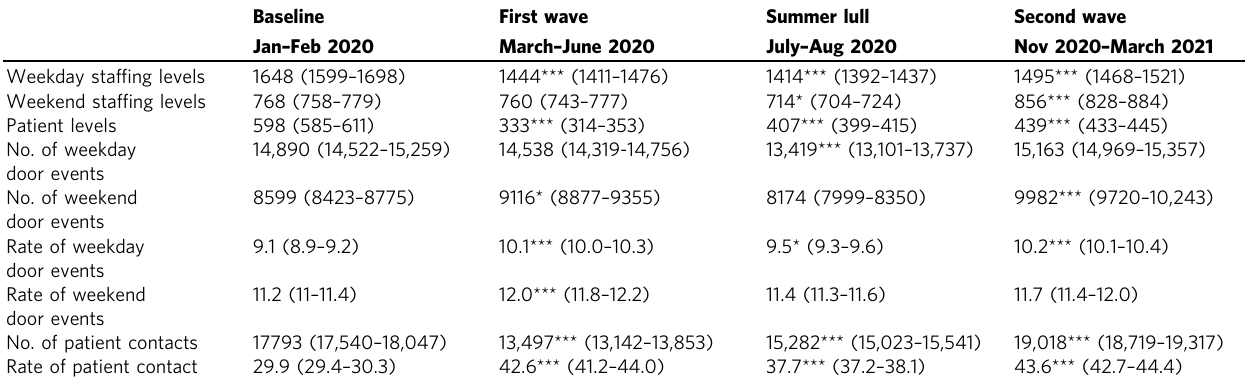
Table 3 Average daily staf fi ng levels, patient levels, rates of healthcare worker mobility and rates of patient contact in the Tower building at University College London Hospital during the fi rst year of the COVID-19